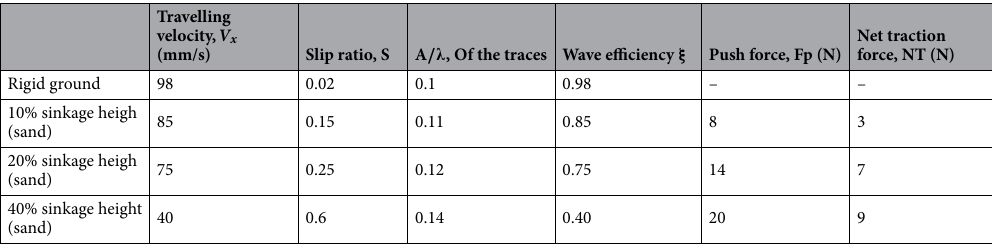
Table 2. The assessment values of the introduced wheel.